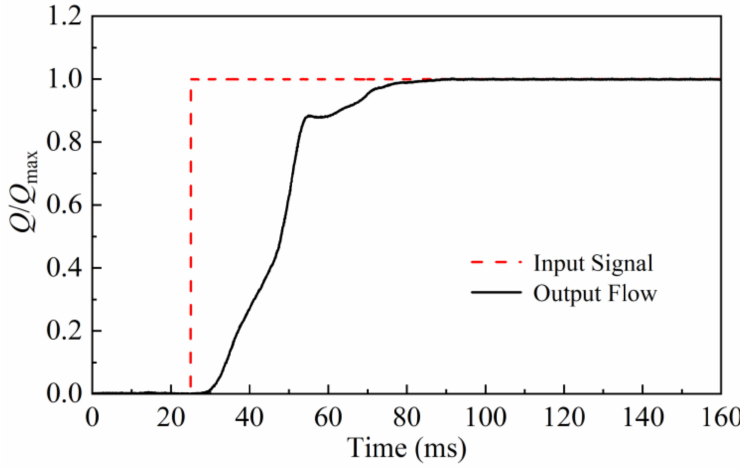
Figure 19. Step response